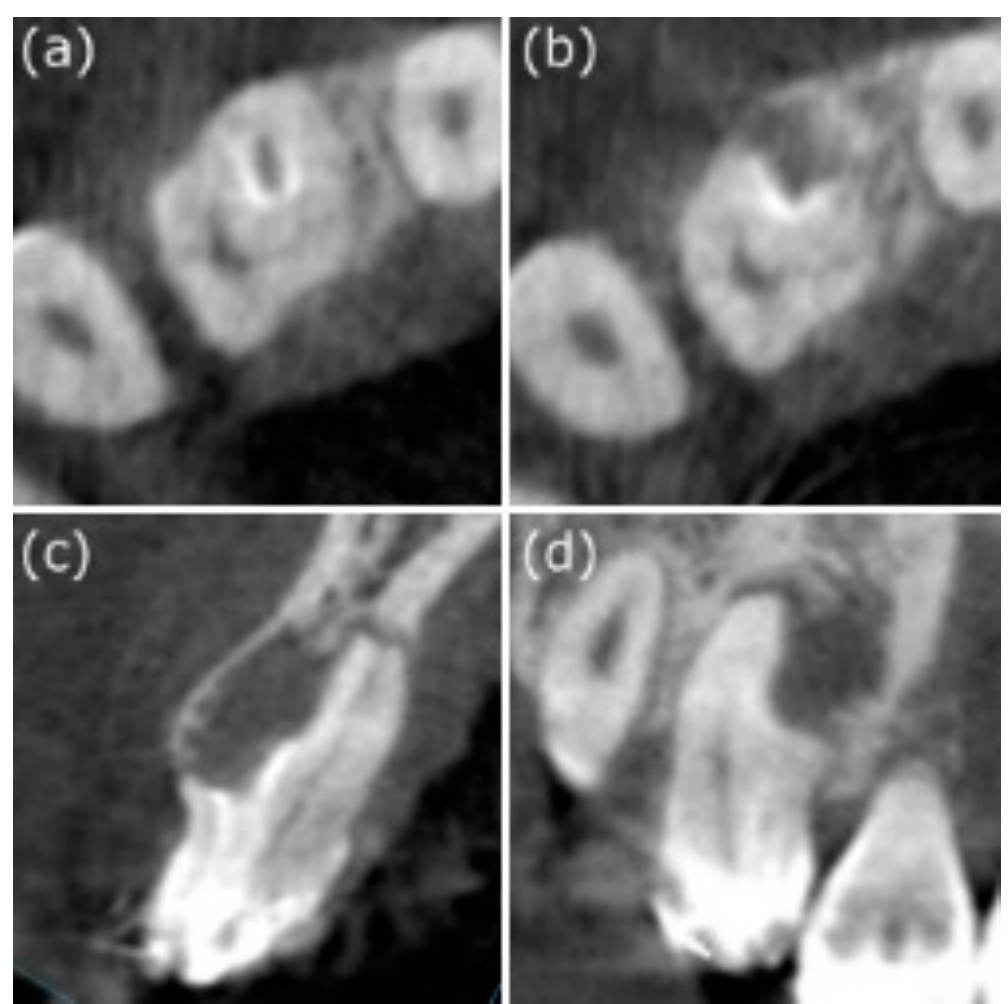
Figure 3. Different sections in cone-beam computed tomography. ( a ) From the axial view, “pseudo-canal” can be observed on the mesial side, surrounded by the enamel. ( b ) The opening of the invagination near CDJ can be seen in the “pseudo- canal”, in the middle-third of the root. ( c ) From the CBCT coronal view, we can observe that the pseudo canal was located near the core part. ( d ) The CBCT sagittal view showing that the buccal side of the pseudo canal with the opening of the invagination near the cemento-enamel junction, and it was adjacent with a well-defined unilocular peri-invagination radiolucent lesion with a size of 8 mm × 9 mm × 12 mm.